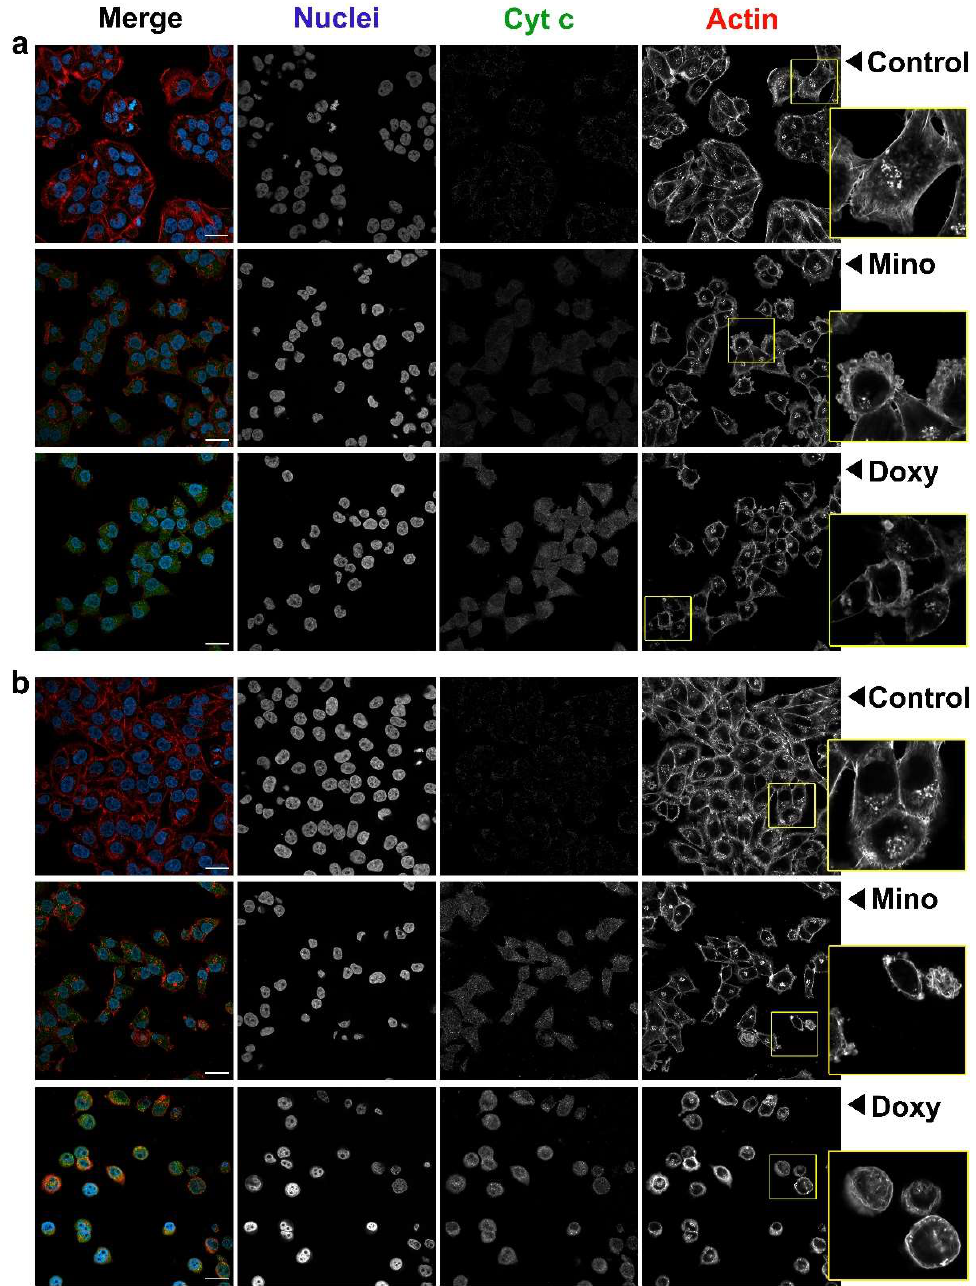
Figure 8. Imaging with confocal microscopy of A375 amelanotic melanoma cells treated with 400 µM minocycline and doxycycline for 24 h ( a ) and 48 h ( b ). Photographs present merged images as well as separate channels for nuclei, cytochrome c, and actin filaments. Scale bar 25 µM.